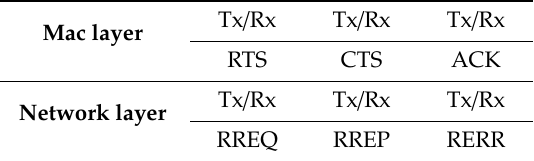
Table 2. Simulation parameters.